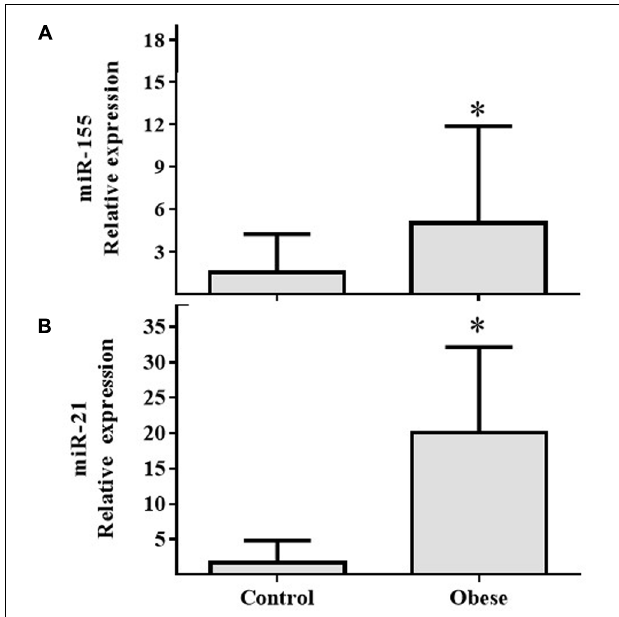
FIGURE 2 | miR-155 and miR-21 levels in PBMCs of the obese subjects compared with the normal weight controls. (A) Differential relative miR-155 expression levels verified by qRT-PCR in the serum samples from normal weight ( n = 17) and obese ( n = 17) subjects ( p = 0.025). (B) Differential relative miR-21 expression levels in the serum samples from normal weight ( n = 17) and obese ( n = 17) subjects ( p = 0.031). Values are median and range interquartile. Mann–Whitney test. ∗ Indicates significant difference.